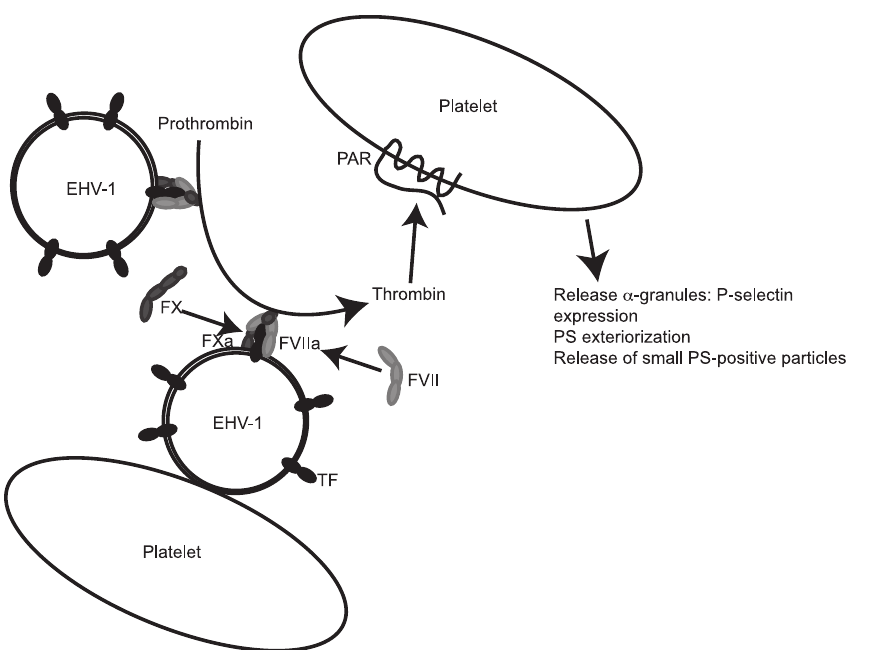
Fig 8. Model for EHV-1-induced activation of platelets. In our model of EHV-1-induced platelet activation, we propose that the virus first binds to platelets. Concurrently, factor VII (FVII) forms a complex with TF in the viral envelope and activates factor X (FX), with FXa generating thrombin in the vicinity of or on the surface of platelets. Thrombin generation may be propagated by phosphatidylserine (PS) in the viral envelope. Thrombin binds to protease-activated receptors (PAR) on platelet surfaces, inducing release of α -granules with subsequent surface P- selectin and PS expression and microvesiculation. If marked, microvesiculation results in loss of membrane-anchored P-selectin on microparticles. Depending on the viral strain or load, thrombin may be generated on the surface of virus not attached to platelets.